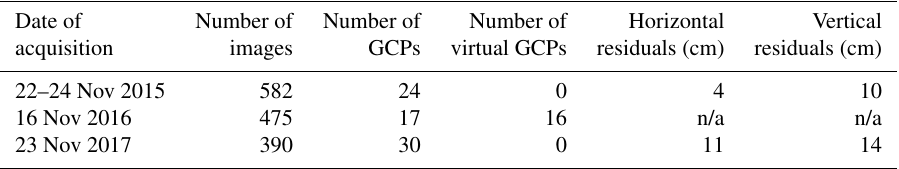
Table 2. Characteristics of the three UAV flights. The horizontal and vertical residuals are assessed on independent additional GCPs. The virtual GCPs are reference points taken in stable ground from the 2015 UAV DEM and orthomosaic, and used as GCPs to derive the 2016 UAV DEM and orthomosaic. For the 2015 and 2017 campaigns, the GCPs were in sufficient number and consequently we did not use virtual GCPs. For the 2016 campaign, we used all the available GCPs to derive the DEM, and consequently could not evaluate the residuals.